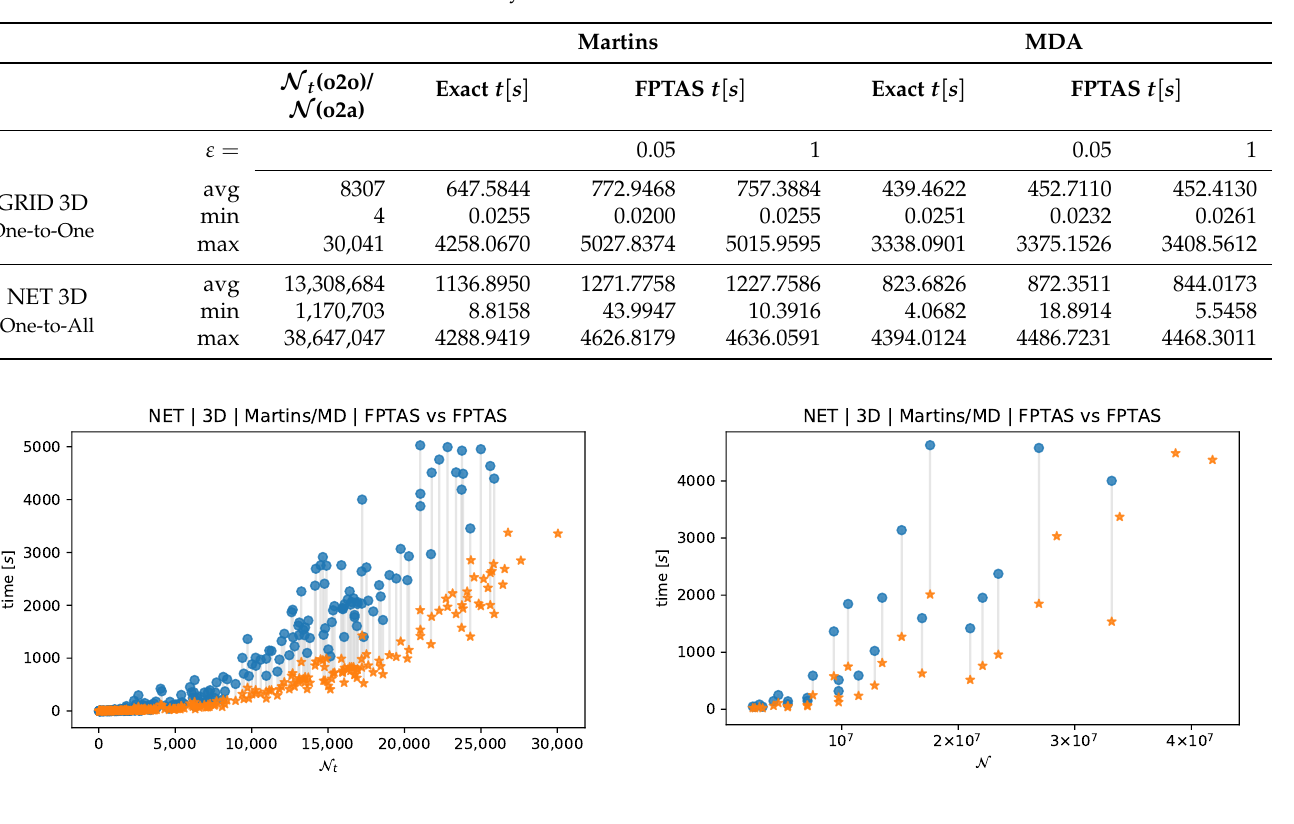
Figure 7. MD-FPTAS (yellow) and Martins-FPTAS (blue) on grid instances ( left ) and netmaker instances ( right